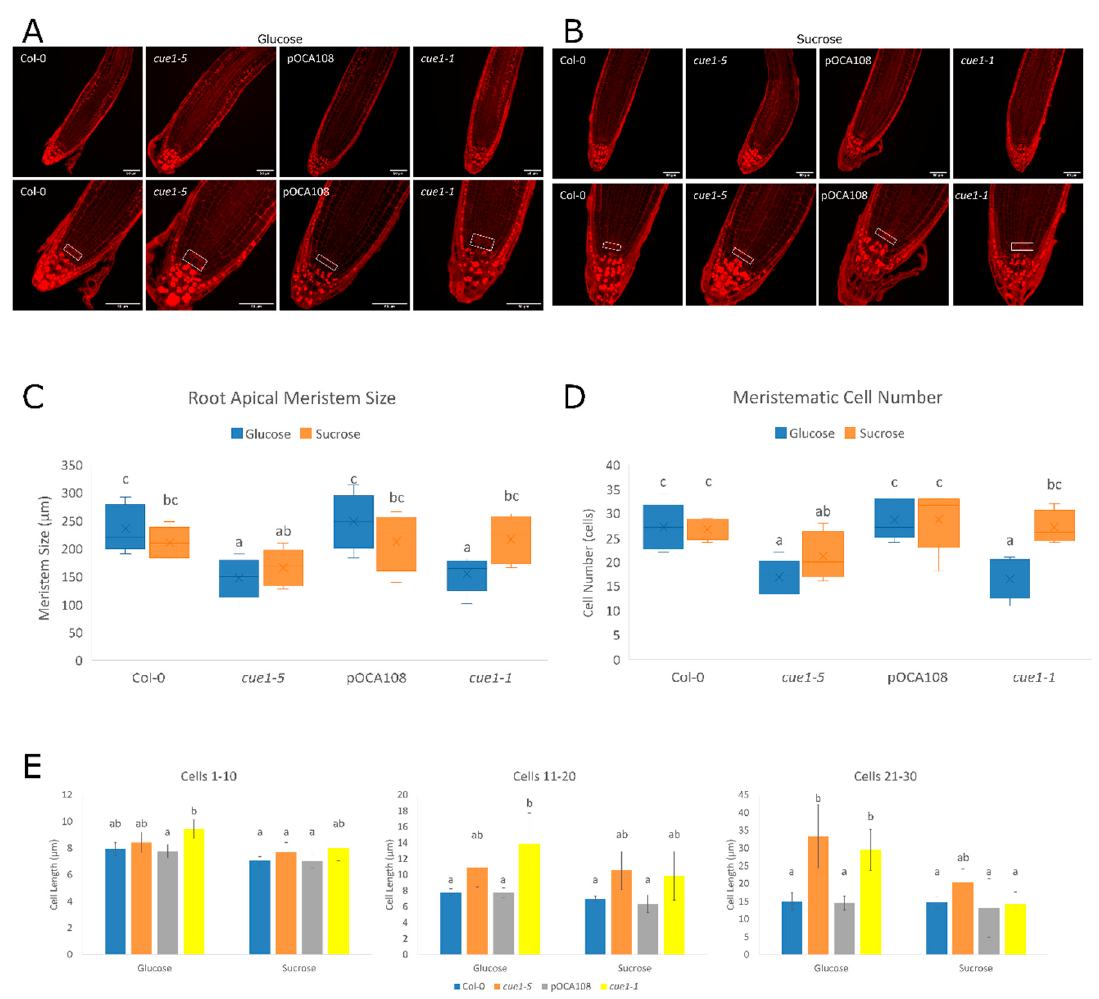
Figure 6. Increased NO causes disorganization of root meristematic stem cells. ( A ) Representative images of the root meristem of 7-day-old seedlings grown on MS-Root medium supplemented with 2%( w / v ) glucose. ( B ) Representative images of the root meristem of 7-day-old seedlings grown on MS-Root medium supplemented with 0.75%( w / v ) sucrose. Seedlings were stained with Schi ff propidium iodide. Scale bars on bottom left corner correspond to 50 µ m. A white rectangle was drawn around the stem cells. Di ff erentiation parameters were quantified from these images. Statistical di ff erences as determined by two-way ANOVA with post-hoc Tukey’s HSD test are represented by di ff erent letters (a–c). ( C ) Meristematic size (F (3,70) = 6.65, p < 0.001, eta2[g] = 0.22). An analysis of simple main e ff ects for each factor was performed with statistical significance after a Bonferroni correction (Table S2). ( D ) Number of cells in the root apical meristem (F (3,70) = 6.16, p < 0.001, eta2[g] = 0.21). An analysis of simple main e ff ects for each factor was performed with statistical significance after a Bonferroni correction (Table S2). ( E ) Bars with common letters (a–c) are not significantly di ff erent according to Welch’s ANOVA with post-hoc Tukey’s HSD test. Average cortical cell sizes are shown for cortical cells 1–10 (F (7,73) = 3.99, p < 0.001), 11–20 (F (7,73) = 5.45, p < 0.001) and 21–30 (F (7,73) = 7.23, p < 0.001) counted from the QC. Values represent the mean ± CI ( n =